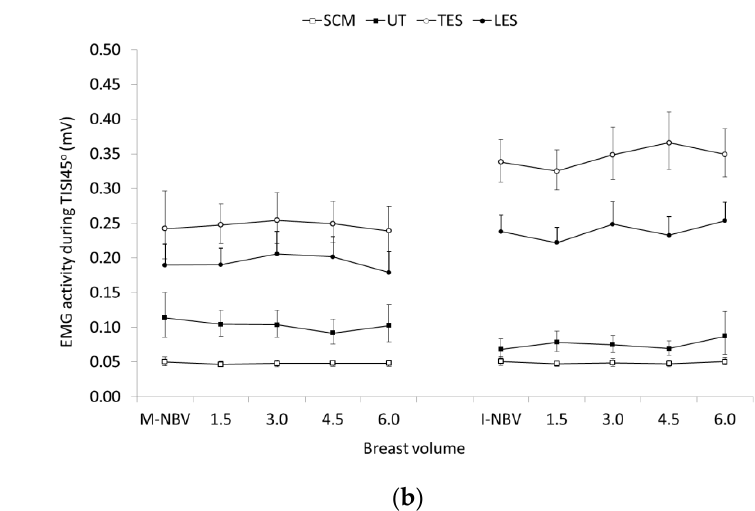
Figure 3. ( a ) The trunk inclination at 45° from the upright sitting posture (TISI45°); ( b ) Geometric means and confidence intervals (error bars) of the sternocleidomastoid (SCM), upper trapezius (UT), and thoracic and lumbar erector spinae (TES and LES) EMG activity in females with minimal and ideal natural breast volume (M-NBV, I-NBV) as well as with increased NBV by 1.5-, 3.0-, 4.5- and 6.0-times during TISI45°.